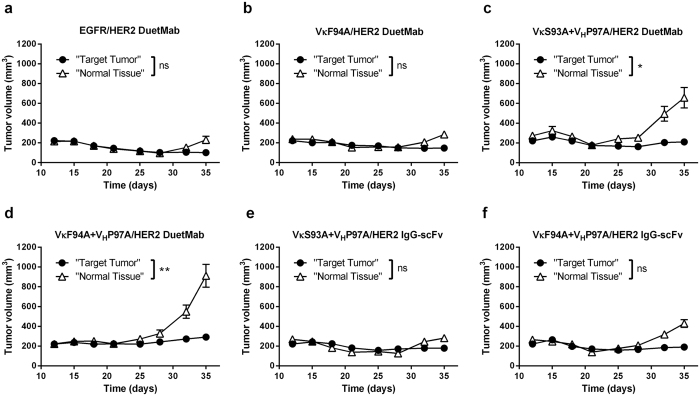
Tumor-targeting selectivity of EGFR affinity-modulated bsAb variants in nude mice bearing dual-flank tumor xenografts.(a) Selective tumor-targeting activity of parental EGFR/HER2 DuetMab. (b) Selective tumor-targeting activity of VκF94A/HER2 DuetMab variant. (c) Selective tumor-targeting activity of VκS93A + VHP97A/HER2 DuetMab variant. (d) Selective tumor-targeting activity of VκF94A + VHP97A/HER2 DuetMab variant. (e) Selective tumor-targeting activity of VκS93A + VHP97A/HER2 IgG-scFv variant. (f) Selective tumor-targeting activity of VκF94A + VHP97A/HER2 IgG-scFv variant. To determine tumor-targeting selectivity, the double-positive NCI-H358 cells as “target tumor” and single-positive NCI-H358.HER2.ko cells as “normal tissue” were grafted on opposing flanks of athymic nude mice. Dual-flank tumor bearing mice were treated twice weekly with the various bsAbs for a total of 8 treatments and selective tumor growth inhibition was measured twice weekly. Tumor size represents the mean values of 8 mice per treatment group and the ± standard error of the mean (SEM) is represented by error bars. Statistical comparisons were conducted by calculating the area under the curve (AUC) of paired “target” and “non-target” tumors, and significance of tumor selectivity was determined by paired t-test (P < 0.05 *P < 0.01 **P < 0.001 ***P < 0.0001 ****ns: not significant).